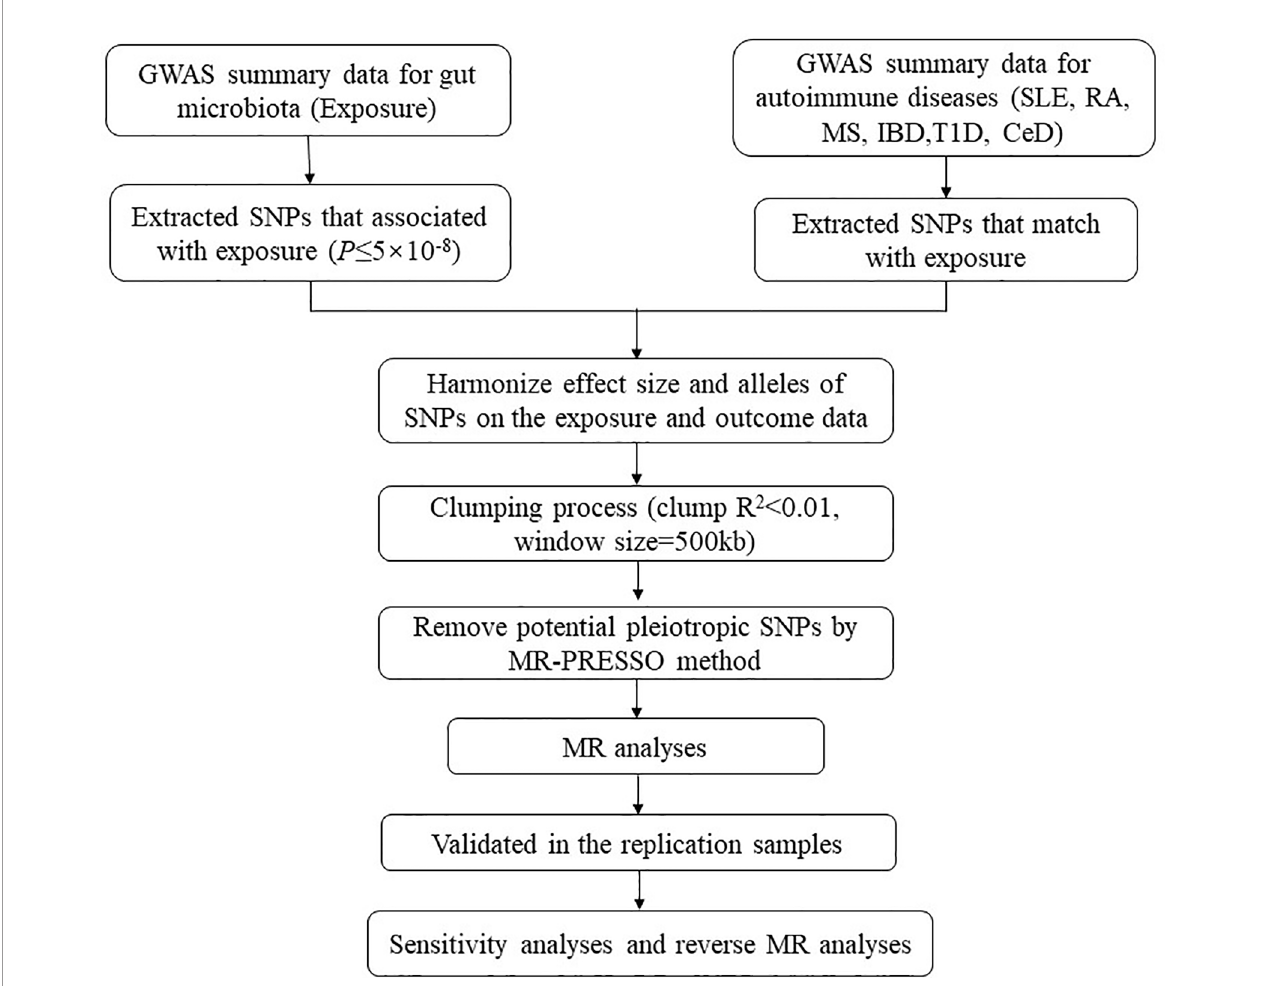
FIGURE 1 | The fl owchart of the study. The whole work fl ow of MR analysis. MR, Mendelian randomization; SLE, systemic lupus erythematosus; RA, rheumatoid arthritis; MS, multiple sclerosis; IBD, in fl ammatory bowel disease; T1D, type 1 diabetes; CeD, celiac